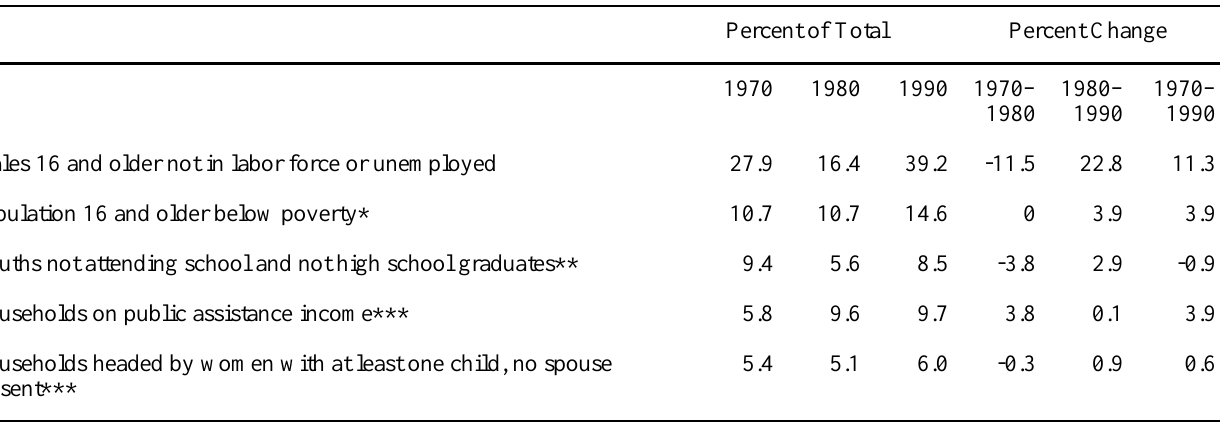
Table 5. Average percentages for underclass indicators in 1970, 1980, and 1990, Pittsburgh Standard Metropolitan Statistical Area